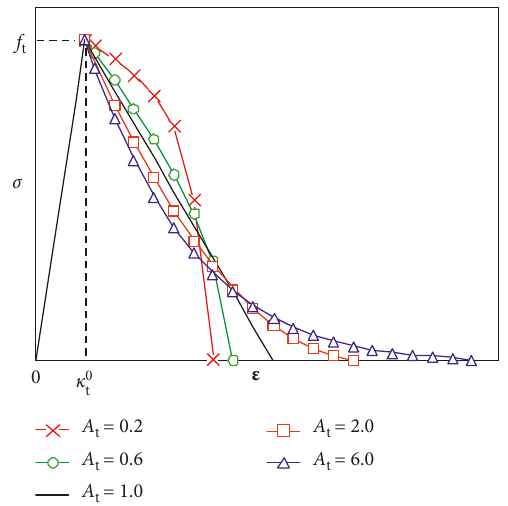
Figure 1: Influence of A t on uniaxial stress-strain relation in